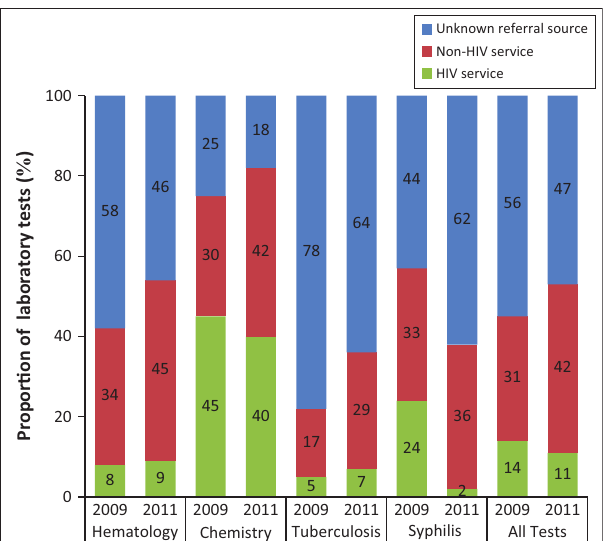
FIGURE 2: Referral sources for laboratory tests performed by PEPFAR-supported laboratories in Tanzania, 2009 and 2011. The graph depicts the overall proportion of laboratory tests performed for patients from different types of referral source (94 laboratories in 2009; 101 laboratories in 2011).